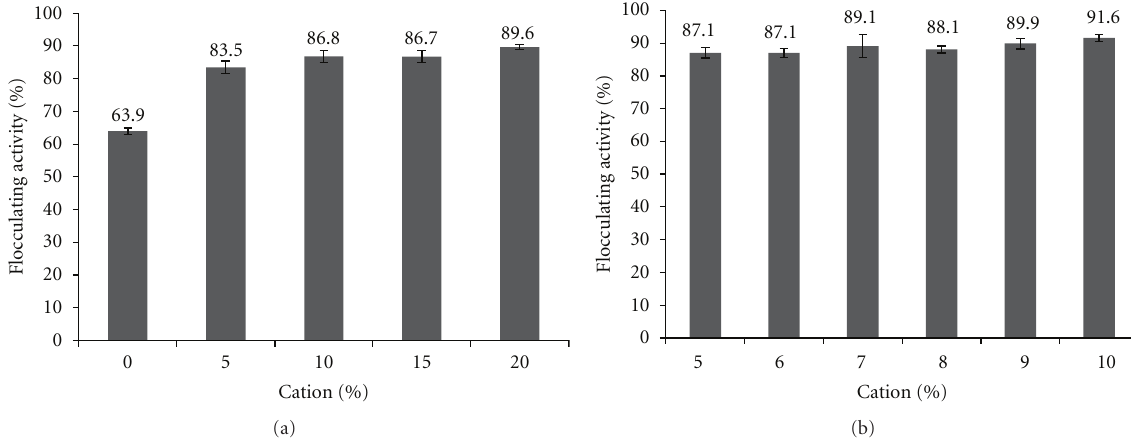
Figure 3: (a) Flocculating activity at di ff erent cation dosage as percentile of total volume of suspension (0–20%). (b) Flocculating activity at di ff erent cation dosage as percentile of total volume of suspension (5–10%).